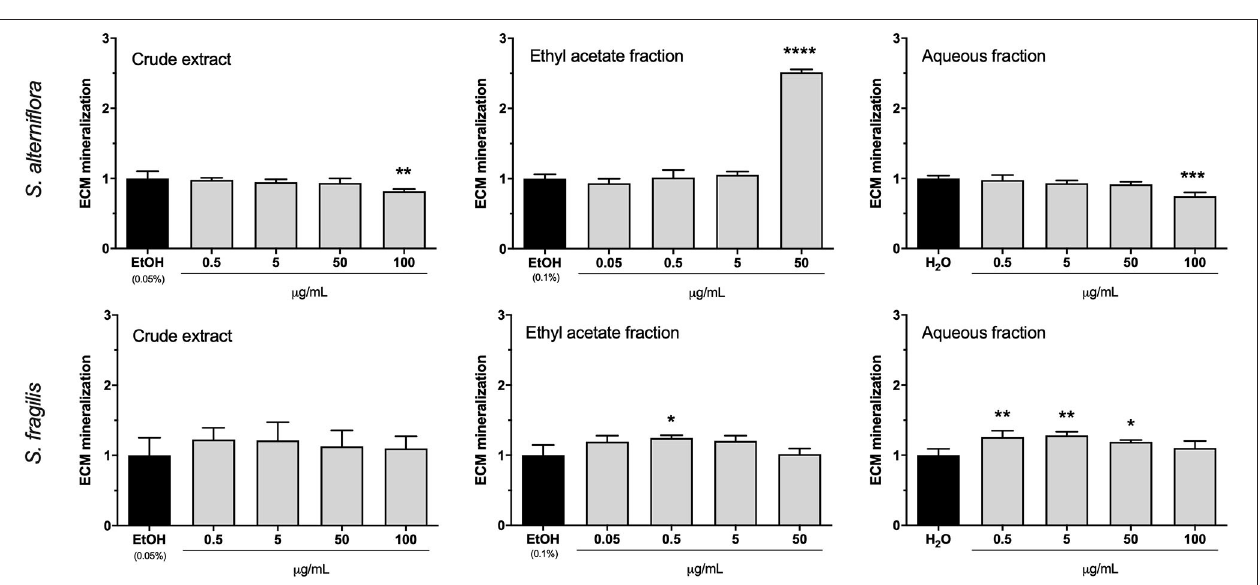
of the new EAF had first to be confirmed and an ORAC value of 1781.63 ± 356.33 µ mol Te g − 1 was measured. This value is in the same range as the one of vitamin C and is 10 times and 17 times higher than the ones for ginger